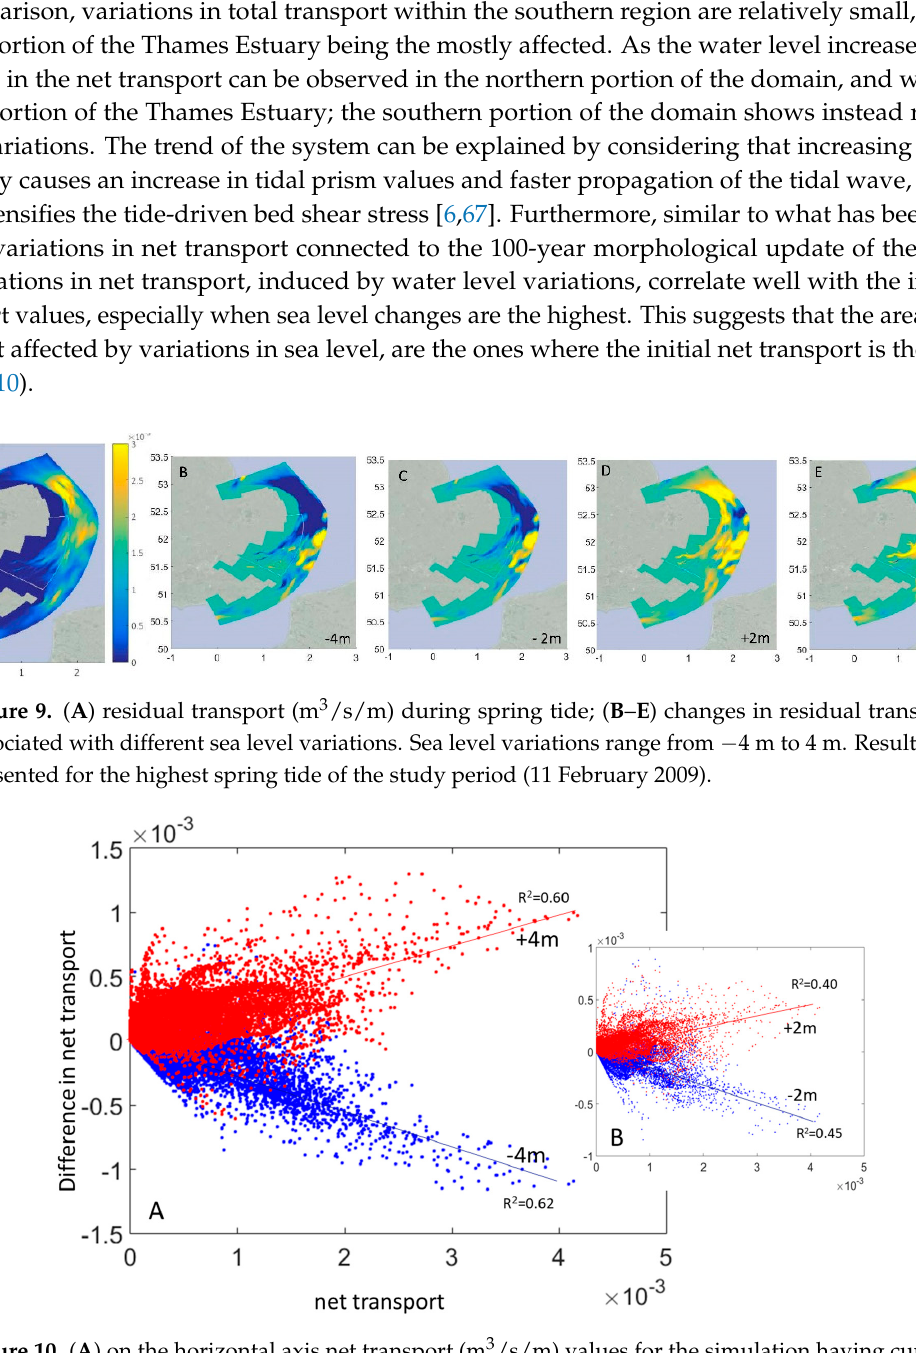
Figure 8. ( A ) residual currents during spring tide; ( B – E ) changes in residual currents associated with different sea level variations. Sea level variations range from − 4m (panel E ) to 4m (panel E ). Results are presented for the highest spring tide of the study period (11 February 2009).